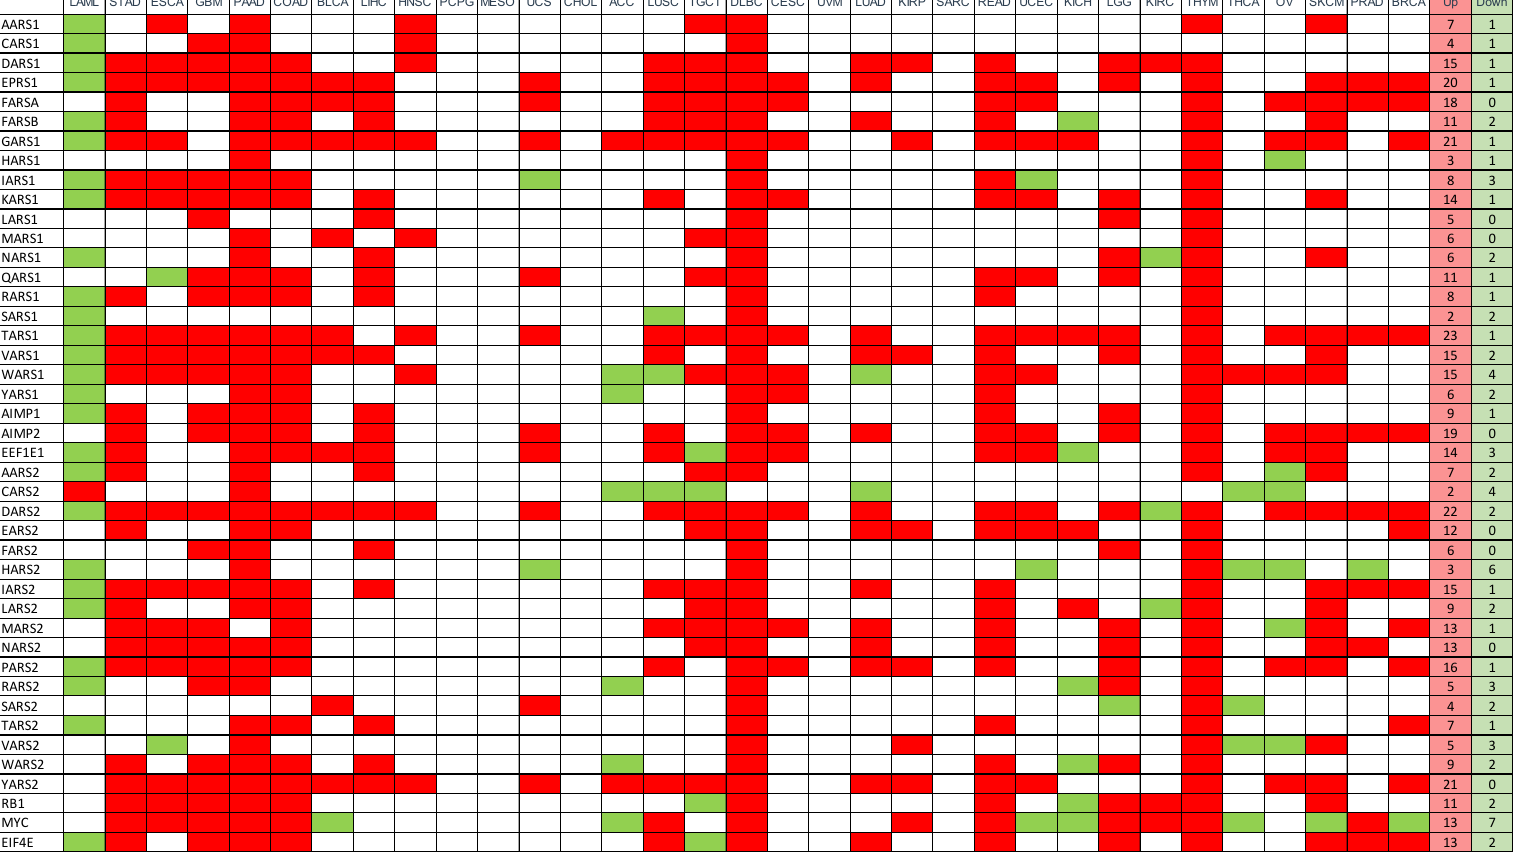
Figure 3. Differential expression of aaRS mRNA across TCGA cancer types. Differential expression was calculated for cytoplasmic and mitochondrial aaRS mRNA expression. Red boxes represent statistically significant (ANOVA, 1.5-fold change, FDR (false discovery rate) adjusted, q -value < 0.05) upregulation in tumor samples compared to normal control tissue and green boxes represent statistically significant downregulation in tumors compared to control. The totals for upregulation and downregulation are tabulated on the right. The 33 cancer types are sorted based on overall survival data from the TCGA database, from shortest median time to event (death) (LAML) to the longest (BRCA).